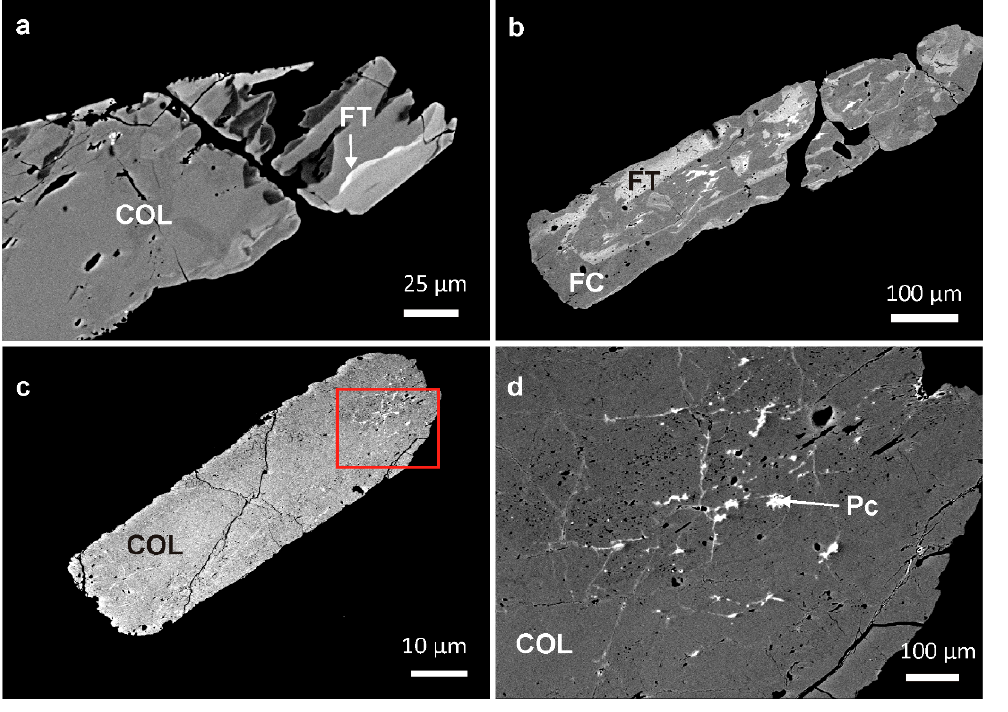
Figure 11. Textural patterns of CGM from type III pegmatites. ( a , b ) Columbite and tantalite with convoluted zoning. ( c ) Unzoned columbite crystal with late pyrochlore replacements. ( d ) detail of the area from image c with replacements by pyrochlore-supergroup minerals (Pc). Col, FC, columbite-(Fe); FT, tantalite-(Fe).